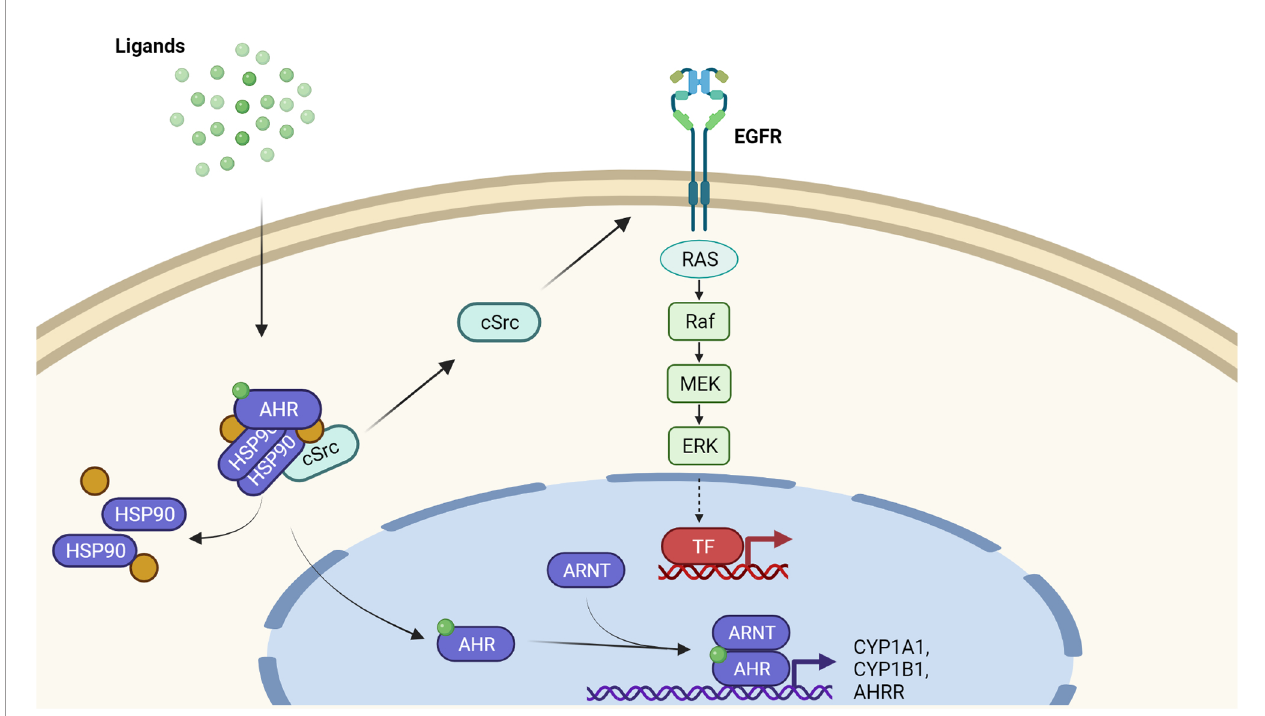
FIGURE 1 | AHR-dependent signaling pathways. Inactive AHR is part of a cytosolic multiprotein. complex consisting of a HSP90 dimer, other chaperone molecules and tyrosine kinase c-Src. Upon ligand binding, the multiprotein complex dissociates and AHR translocates into the nucleus. Nuclear AHR heterodimerizes with ARNT and binds to the enhancer region of target genes, for instance encoding CYP1A1, CYP1B1, and AHRR, to enhance their expression. In addition to this canonical pathway, the AHR ligand-driven release of c-Src from the cytosolic multiportion complex may stimulate EGFR and downstream mitogen-activated protein kinases, resulting in the transcriptional induction of another set of